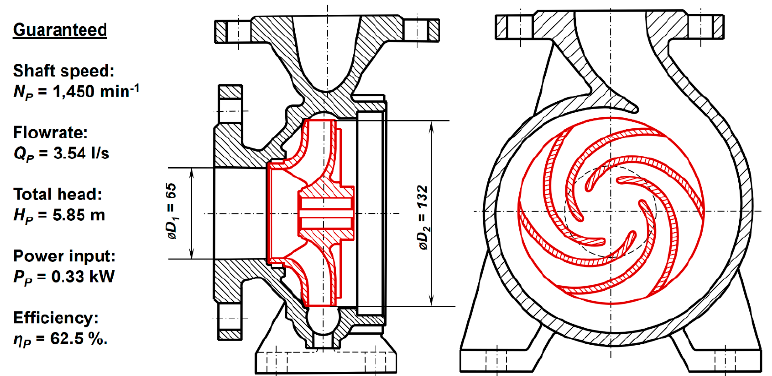
Figure 3. Pump used for experimental tests.